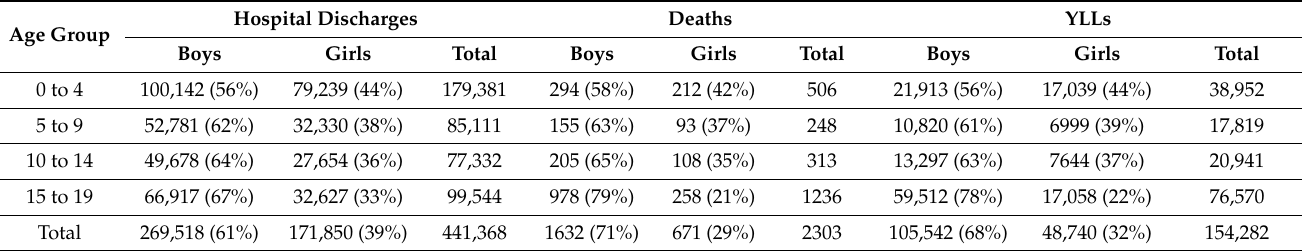
Table 1. Counts and relative distribution of hospital discharges, deaths and YLLs due to TBI by age and sex in 2014 in the analyzed countries.